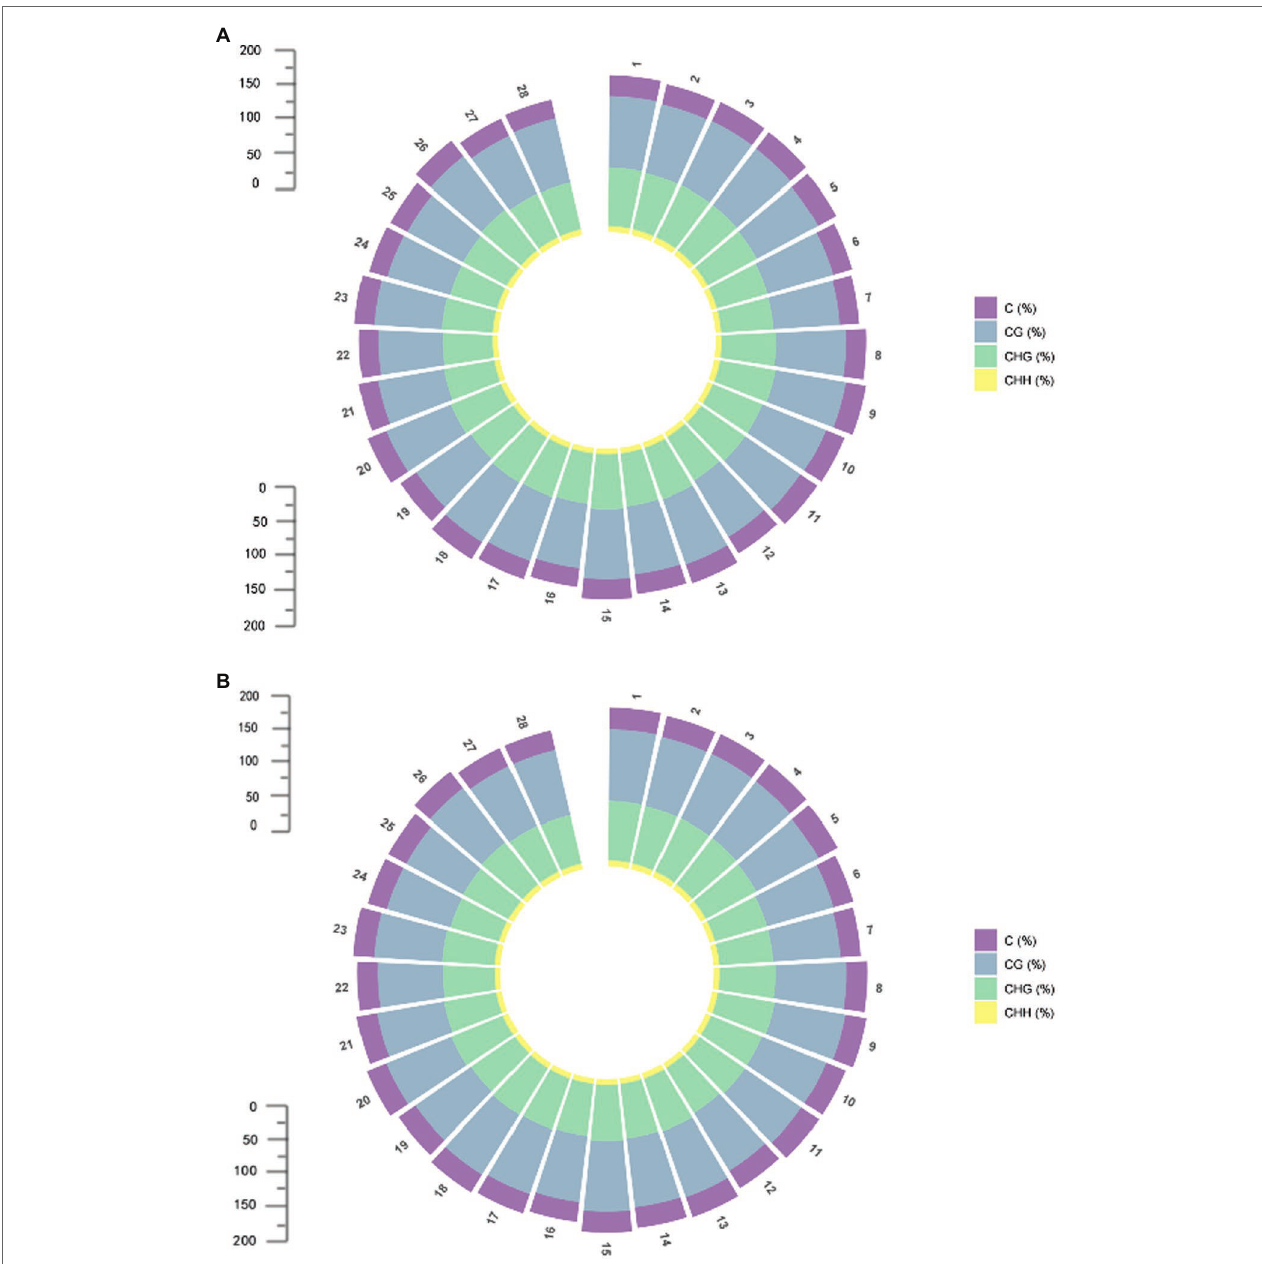
FIGURE 3 | Methylation distribution of each chromosome; (A) Methylation distribution of each chromosome in 07-113A. (B) Methylation distribution of each chromosome in